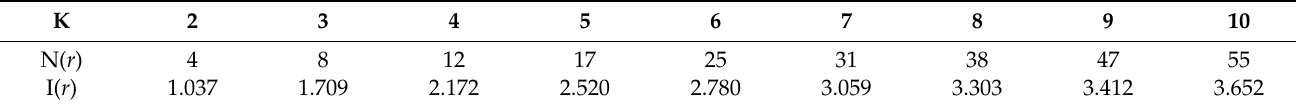
Table 2. Network dimension measurement data of Guangdong’s rural tourism resources.